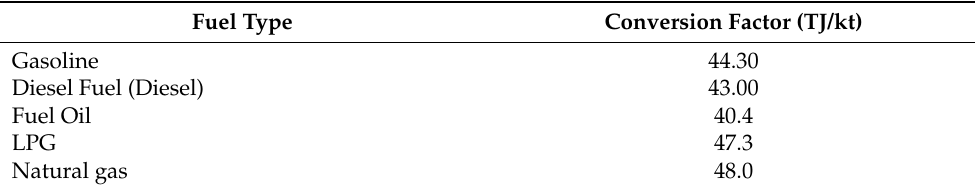
Table 2. Fuel conversion factors